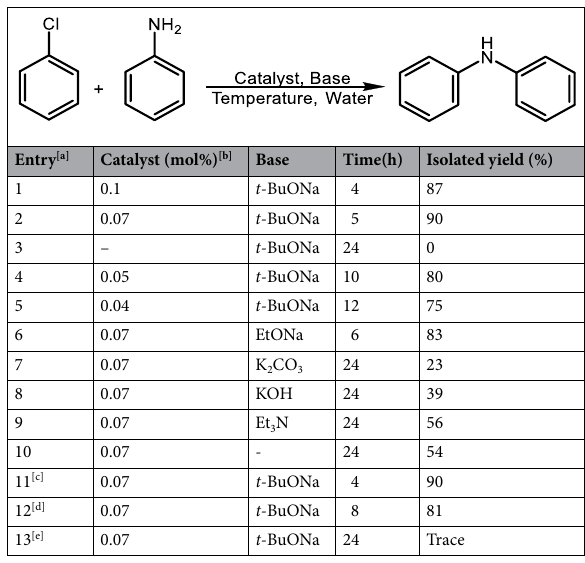
Table 4. Buchwald–Hartwig amination reaction of chlorobenzene with aniline catalyzed by γ-Fe 2 O 3 @ MBD/Pd-Co under different conditions in water. [a] Reaction conditions: chlorobenzene (1 mmol),